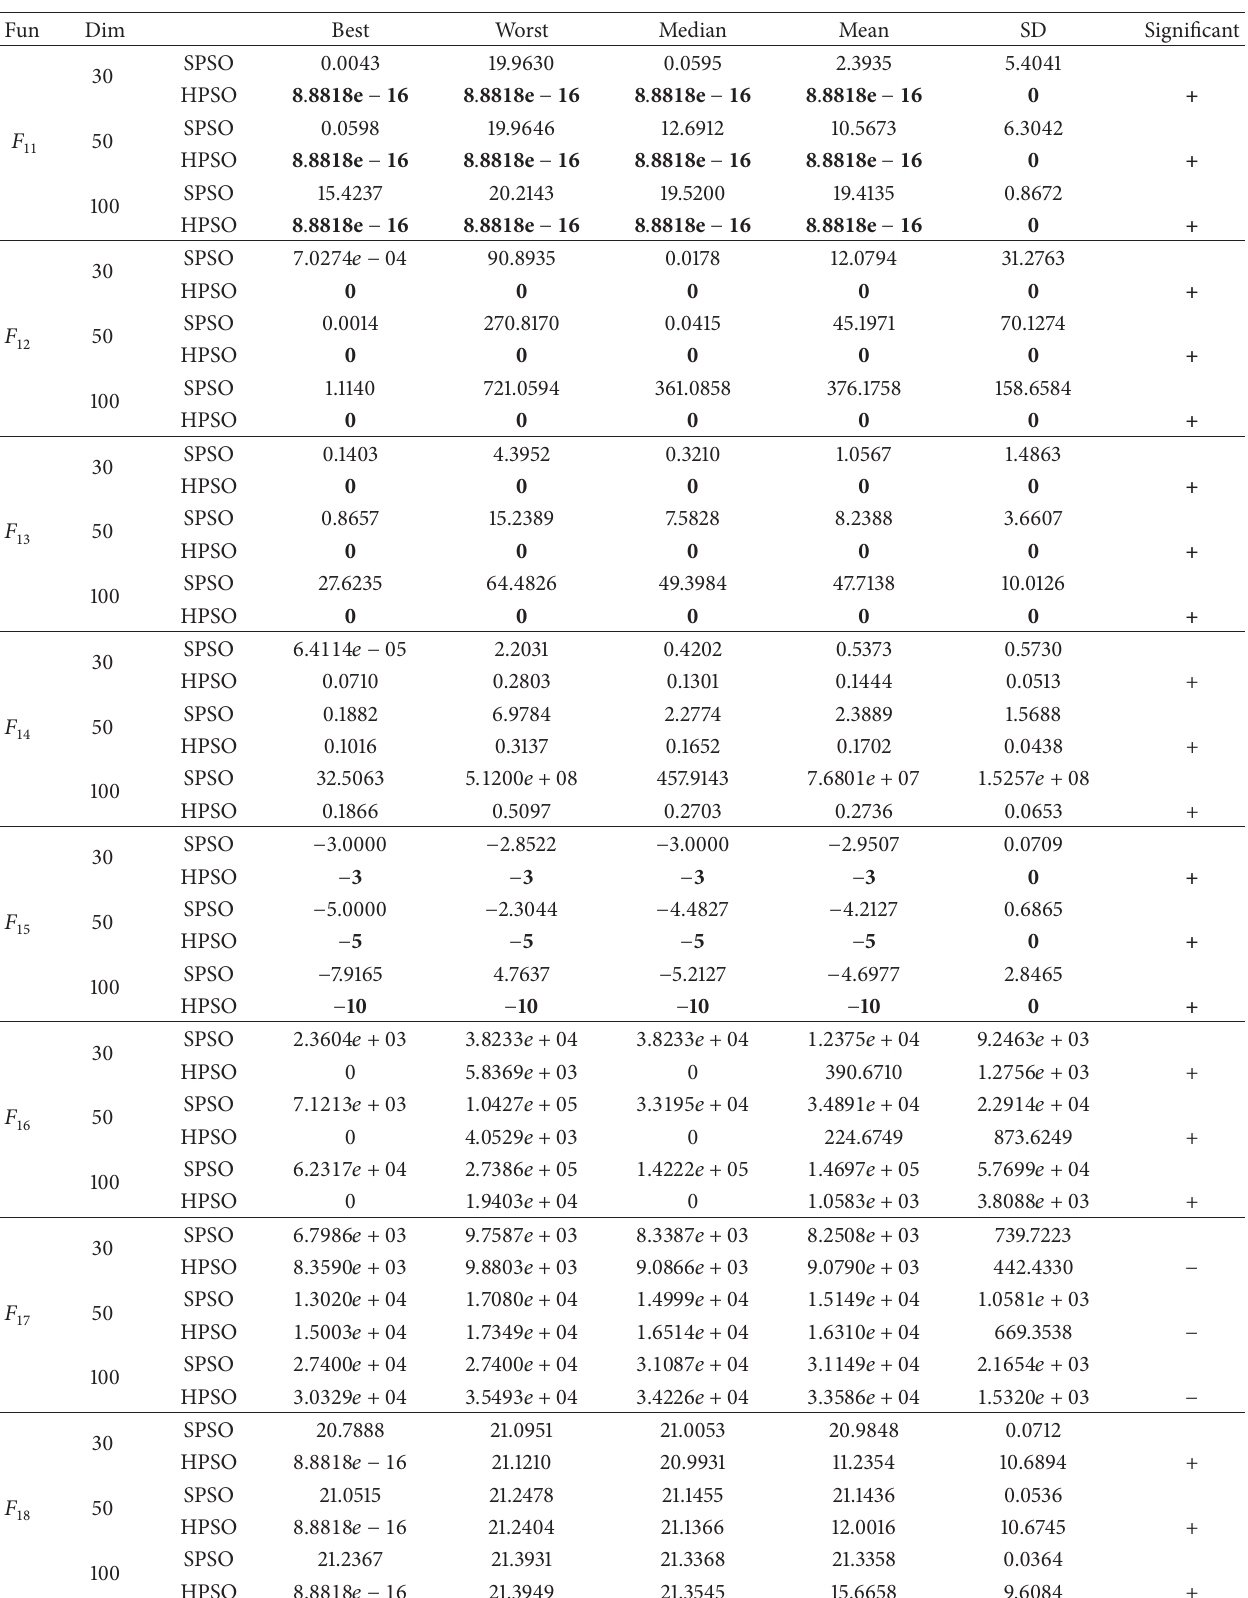
Table 3: Experimental results obtained by SPSO and HPSO on functions from 𝐹 11 to 𝐹 20